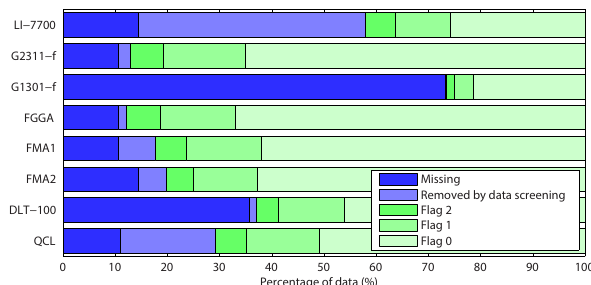
Figure 3. Distribution of quality flags for CH 4 fluxes during the campaign. Quality flags were given according to flux stationarity criteria (Foken and Wichura, 1996). Flag 0 (flux stationarity be- low 0.3) corresponds to the highest quality, flag 1 (flux stationar- ity between 0.3 and 1) to medium quality and flag 2 to the lowest quality (flux stationarity above 1). Green bars show the amount of accepted data and blue bars shown the amount of omitted data. LI- 7700 data are affected by an external data-logging problem which is not caused by the